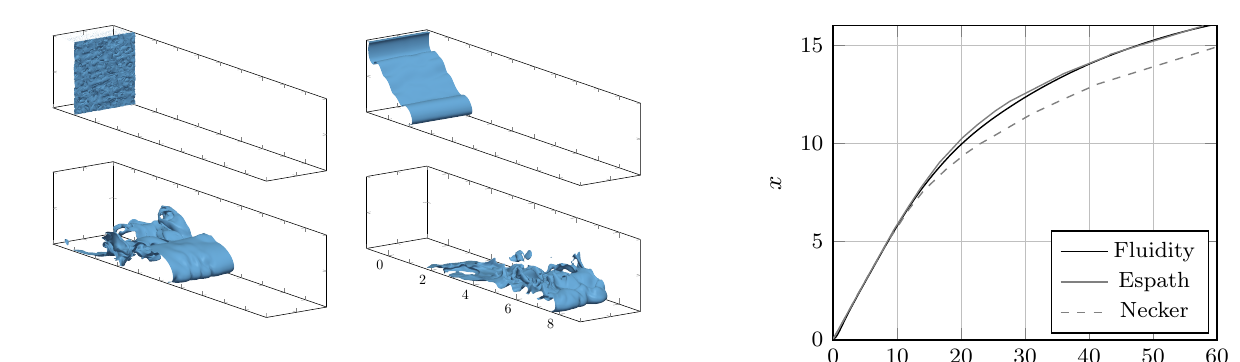
Figure 10. Propagation of density interface over time. This figure shows a contour at a concentration 0 . 25 at times 0, 2, 8 and 14.